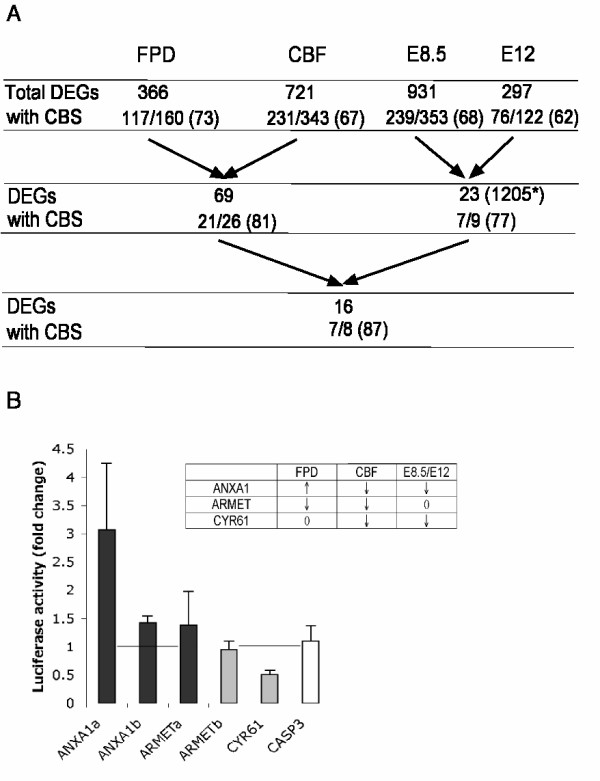
A. Overlaps between the datasets and percentage of genes with a RUNX1 binding site in their regulatory regions. The overlaps between the different platforms are represented with arrows. * indicates that the genes differentially expressed in at least one of the mouse datasets are considered for the following overlap. The number of differentially expressed genes (DEGs) containing a conserved RUNX1 binding site (with CBS) in their regulatory regions, as determined by the oPOSSUM program [27], over the number of analyzed genes is indicated for each dataset and overlap. The corresponding percentage is indicated in brackets. B. Luciferase assay for 5 RUNX1 binding sites corresponding to 3 differentially expressed genes. The transactivation activity of RUNX1 over these sites was measured as the fold change of the luciferase activity in the presence of the CBF complex compared to the endogenous activity of each construct. The standard errors of three independent replicates are shown. CASP3 was shown as a negative control as no binding site was found for this gene. The difference in expression for the three genes in each dataset is indicated in the table. 0 means no difference in expression, ↓ stands for down-regulated and ↑ stands for up-regulated.